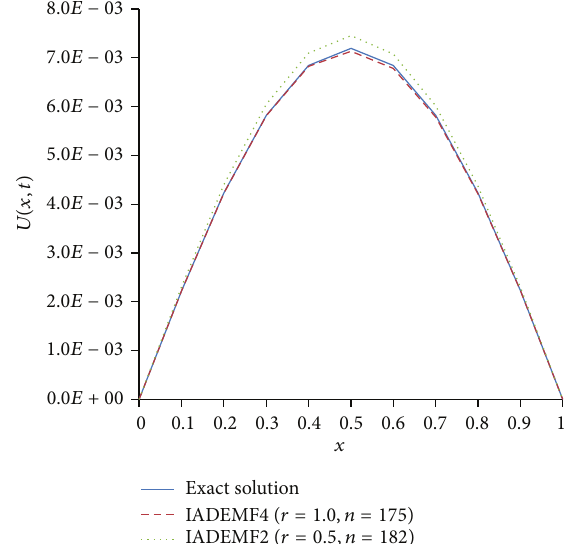
Figure 9: Numerical and exact solutions for Experiment 2. 𝜆 = 1.0 , Δ𝑥 = 0.1 , Δ𝑡 = 0.01 , 𝑡 = 0.5 , and 𝜀 = 10 −4 .